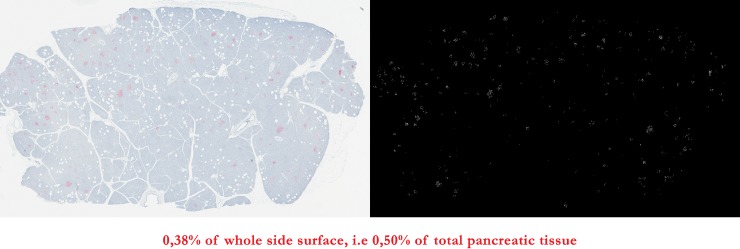
Example on the slide 14262.Selected Fast Red-stained pixels and subsequent results. Given that these 3 different areas were evaluated on pictures of different sizes (full-resolution picture for Fast Red-stained area versus resized pictures for total and exocrine+endocrine pancreatic tissue areas), all the results were normalized by the whole slide surface to allow further calculation of the parameters of interest, i.e. ratio of non-exocrine-non-endocrine pancreatic tissue (total pancreatic tissue minus exocrine+endocrine pancreatic tissue) to total pancreatic tissue area and ratio of either α-or β-cell area to total pancreatic tissue area, further converted into mass by multiplication by pancreas weight when this data was available. To take into account the difference in tissue area between slides, the average calculated for each patient, on respectively 6 slides for the ratio of non-exocrine-non-endocrine pancreatic to total pancreatic tissue, 4 slides for the ratio of α- cell area to total pancreatic tissue ratio and 2 slides for the ratio of β-cell area to total pancreatic tissue ratio, was weighted according to the total pancreatic tissue area of each slide.